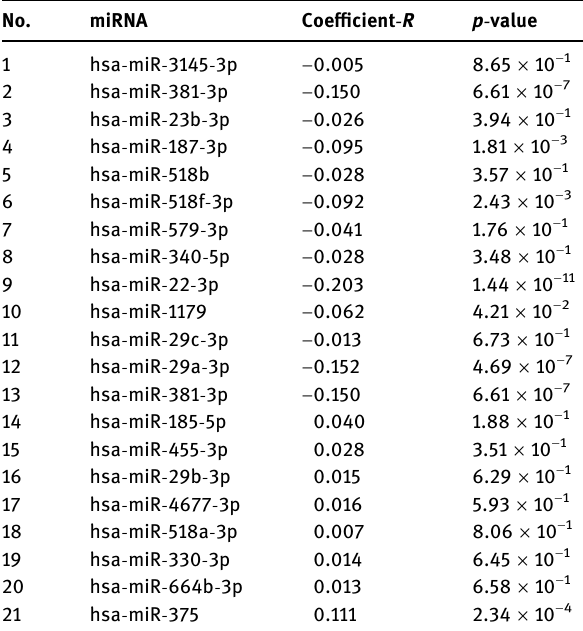
Table 4: Correlation of miRNA - LIG3 pairs identi fi ed by the ENCORI